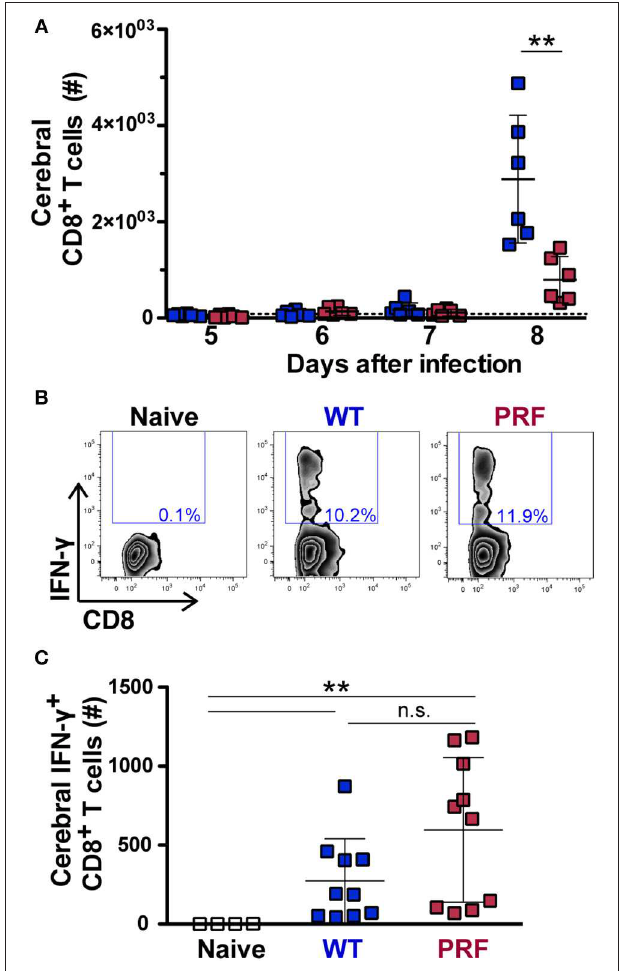
FIGURE 4 | Quantification of total and antigen-experienced CD8 + T cells in the brains of infected mice. (A) Time course of total cerebral lymphocyte counts during the late stages of blood infection. Mice were infected with WT (blue) or PRF (red) sporozoites by intravenous injection ( n = 6 each), and cerebral lymphocytes were isolated and analyzed at indicated time points. Shown are total CD8 + T cell numbers. The dotted line represents the mean cerebral CD8 + T cell number in all naïve animals ( n = 16). The scatter dot plots represent mean values ( ± SD ). ** P < 0.01 (Mann-Whitney test). (B) Gating strategy for detection of intracellular IFN- γ expression in CD3 + CD8 + cells after re-stimulation with Pb GAP50 40 − 48 peptide. Shown are representative plots for naïve animals, as well as mice infected with WT or PRF sporozoites. (C) Quantification of cerebral CD8 + T cells expressing intracellular IFN- γ after re-stimulation with Pb GAP50 40 − 48 peptide. Shown are numbers of this population in the brain. The scatter dot plots represent mean values ( ± SD) from samples isolated on day 8 from three independent experiments ( n = 10 each for infected mice; n = 4 for naïve mice). IFN- γ -secreting antigen-specific CD8 + T cells number from WT vs. PRF infected animals is non-significant. ** P < 0.01 (Mann-Whitney